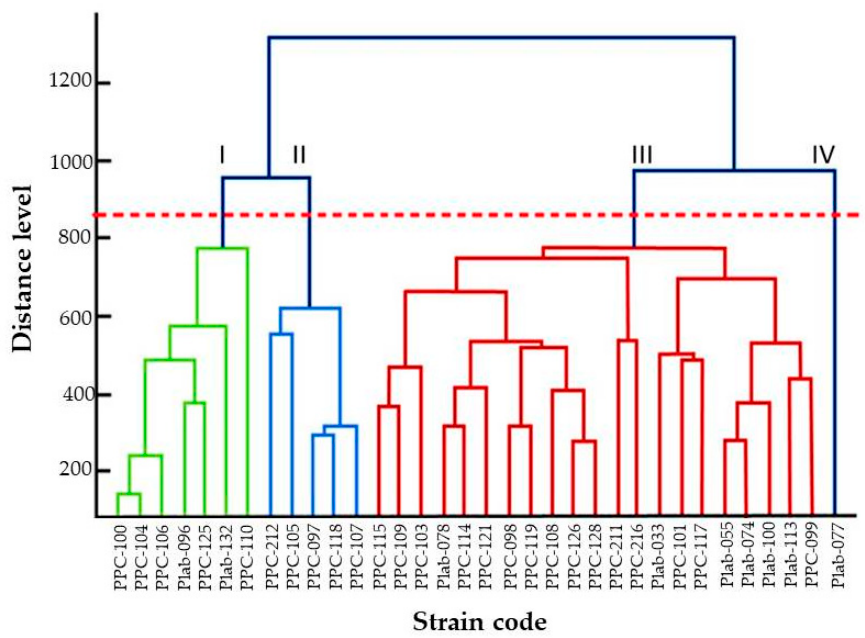
Figure 3. Principal component analysis (PCA) dendrogram generated by MALDI Biotyper mass spectra of 34 clinical isolates of N. dimidiatum . Four groups of populations are observed (I to IV) above the 850 distance level.